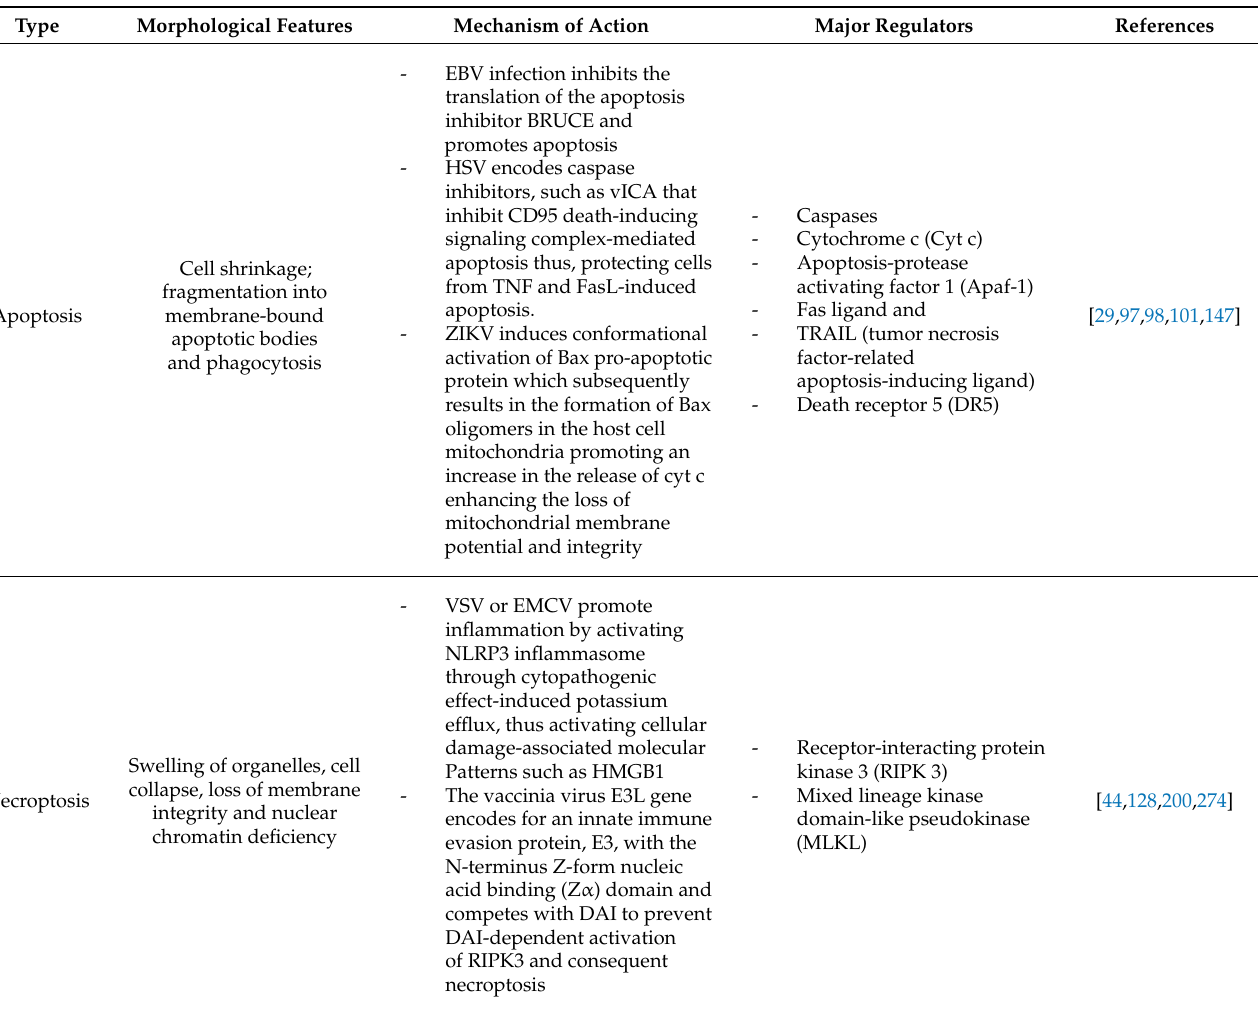
Table 1. Summary of viral infection mediated known and lesser-known RCD (regulated cell death)